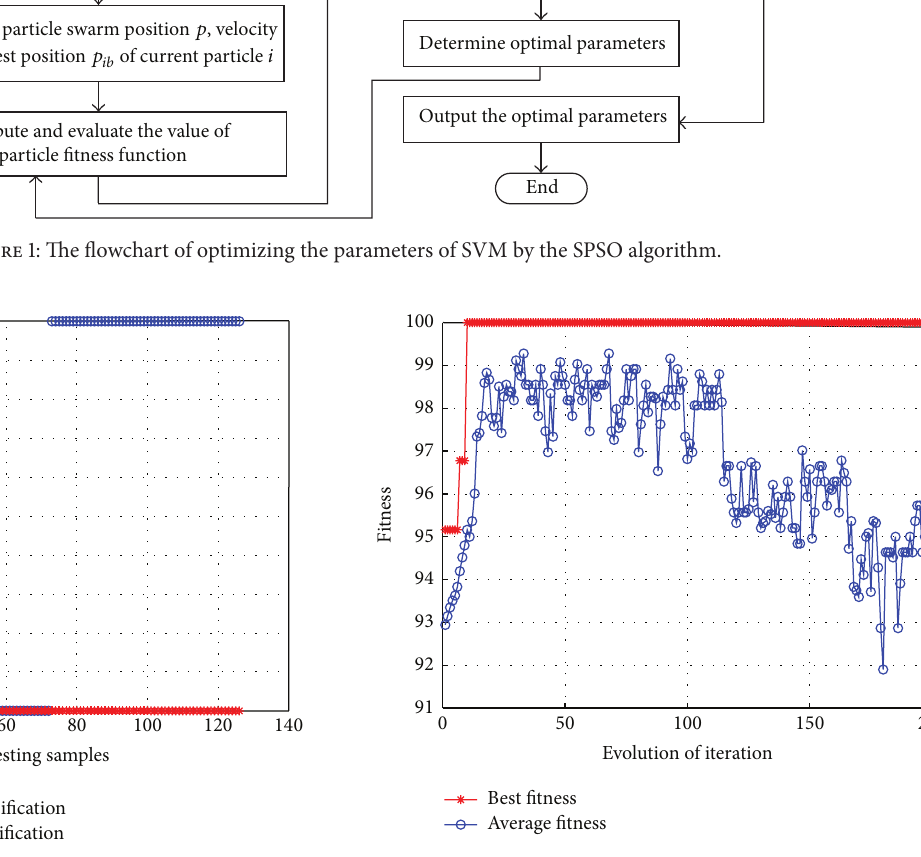
Figure 3: The fitness curve of searching for the best parameters by the GA